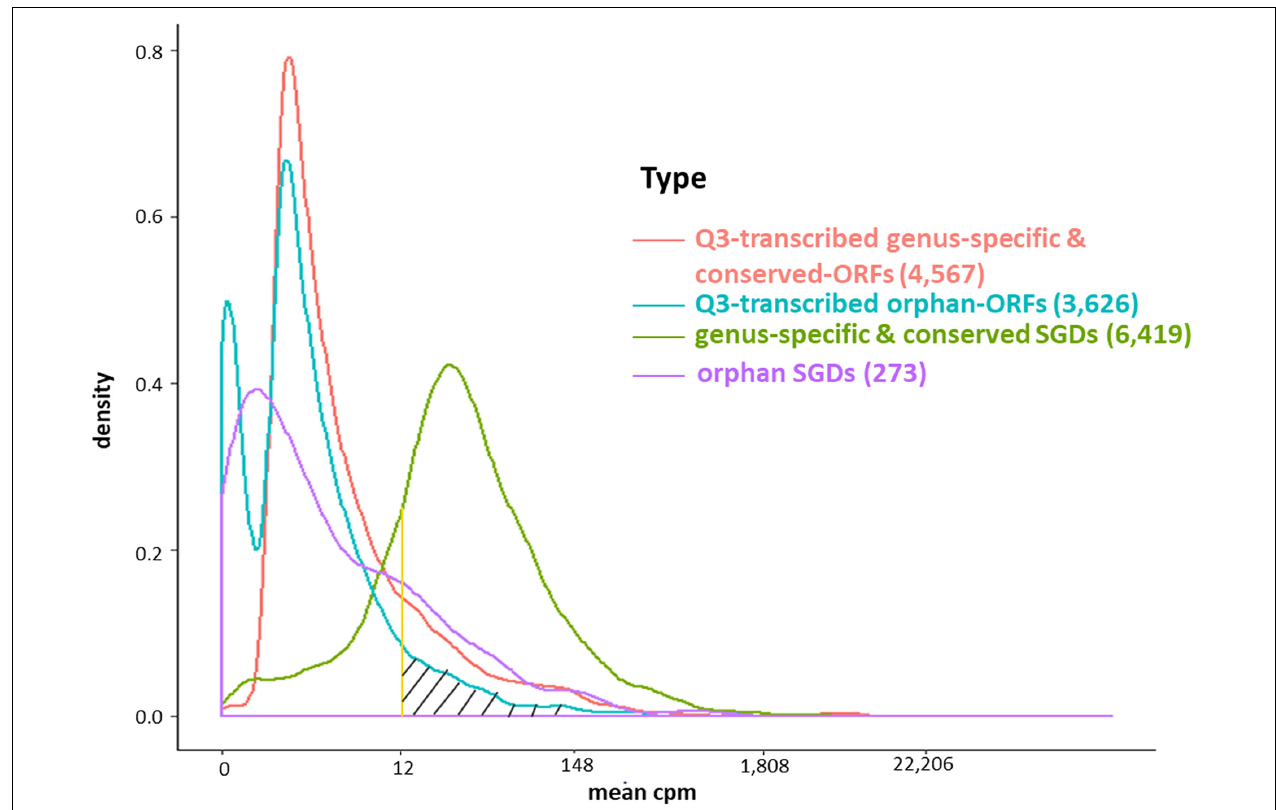
FIGURE 4 | Density plot of mean expression level of transcripts across 3,457 samples for annotated genes and Q3-transcribed ORFs. X -axis, edgeR -normalized mean expression of genes and ORFs. Y -axis, number of transcripts. The area under the curve of the density function represents the probability of a range of mean cpm. The bimodal curve of all orphan-ORFs is attributable to the low mean expression of the smORFs (see Supplementary Figures 10 , 11 ). About half of the Q3-transcribed orphan-ORFs have higher mean expression than annotated orpahn genes. Over 600 orphan-ORFs have a higher mean expression than 10% of annotated conserved genes; 289 orphan-ORFs (gray hatched area) have a higher mean expression than 25% of annotated conserved genes; and, 36 orphan-ORFs have a mean expression higher than 90% of annotated conserved genes (see also Supplementary Table 4 ).